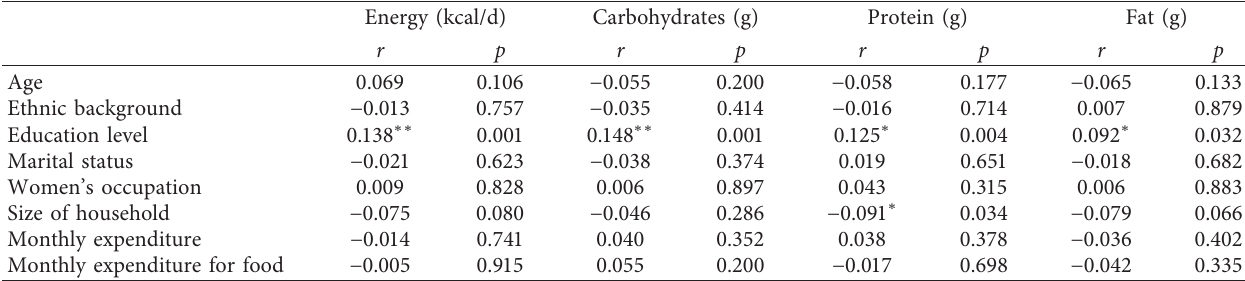
Table 4: Association of energy and macronutrients intakes with weight status and demographic and socioeconomic factors among the study